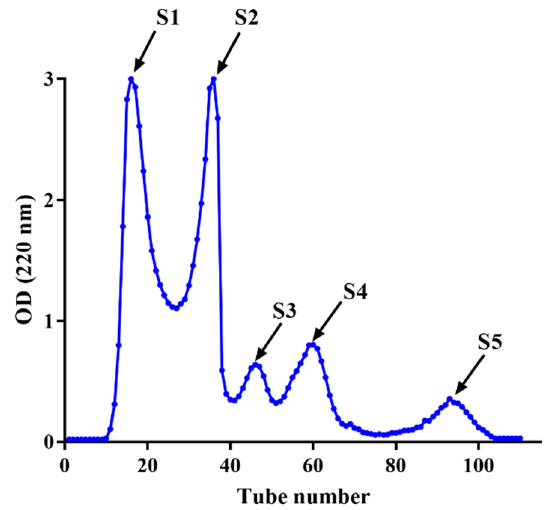
Figure 2. Purification of HPM-3 by Sephadex G-25 gel chromatography.